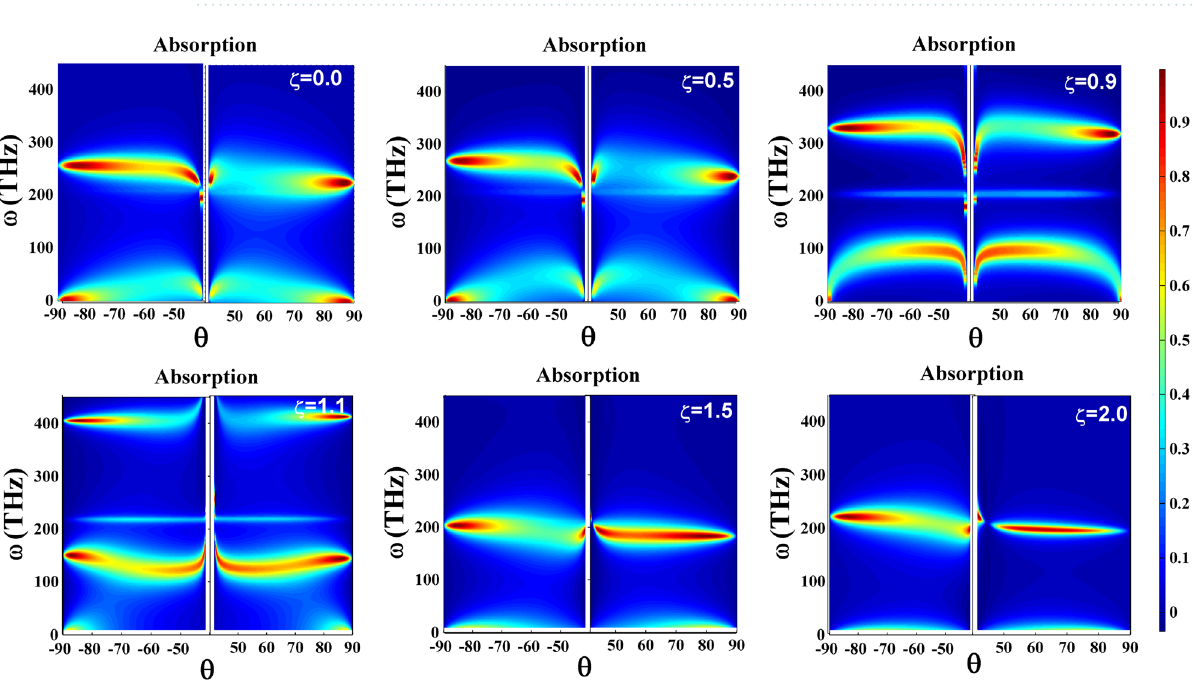
Figure 5. Absorption spectrum (A) of TM-plarized light incident on TWSM thin film in the Voigt configuration with the thickness a terms of frequency and incident angle for different values of tilt parameter ζ parameters are the same as Fig.